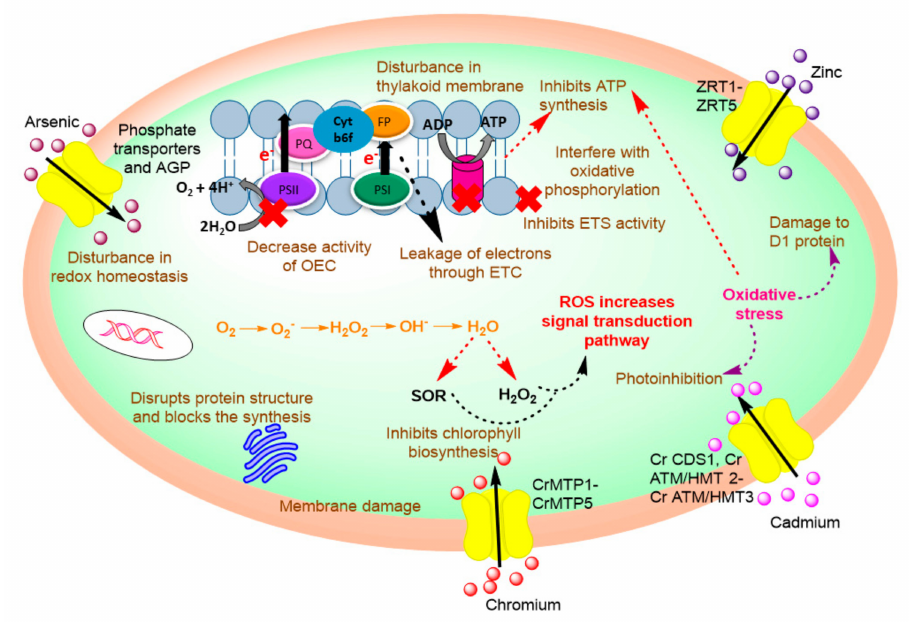
Figure 3. Sites of action of heavy metal and their toxicity in